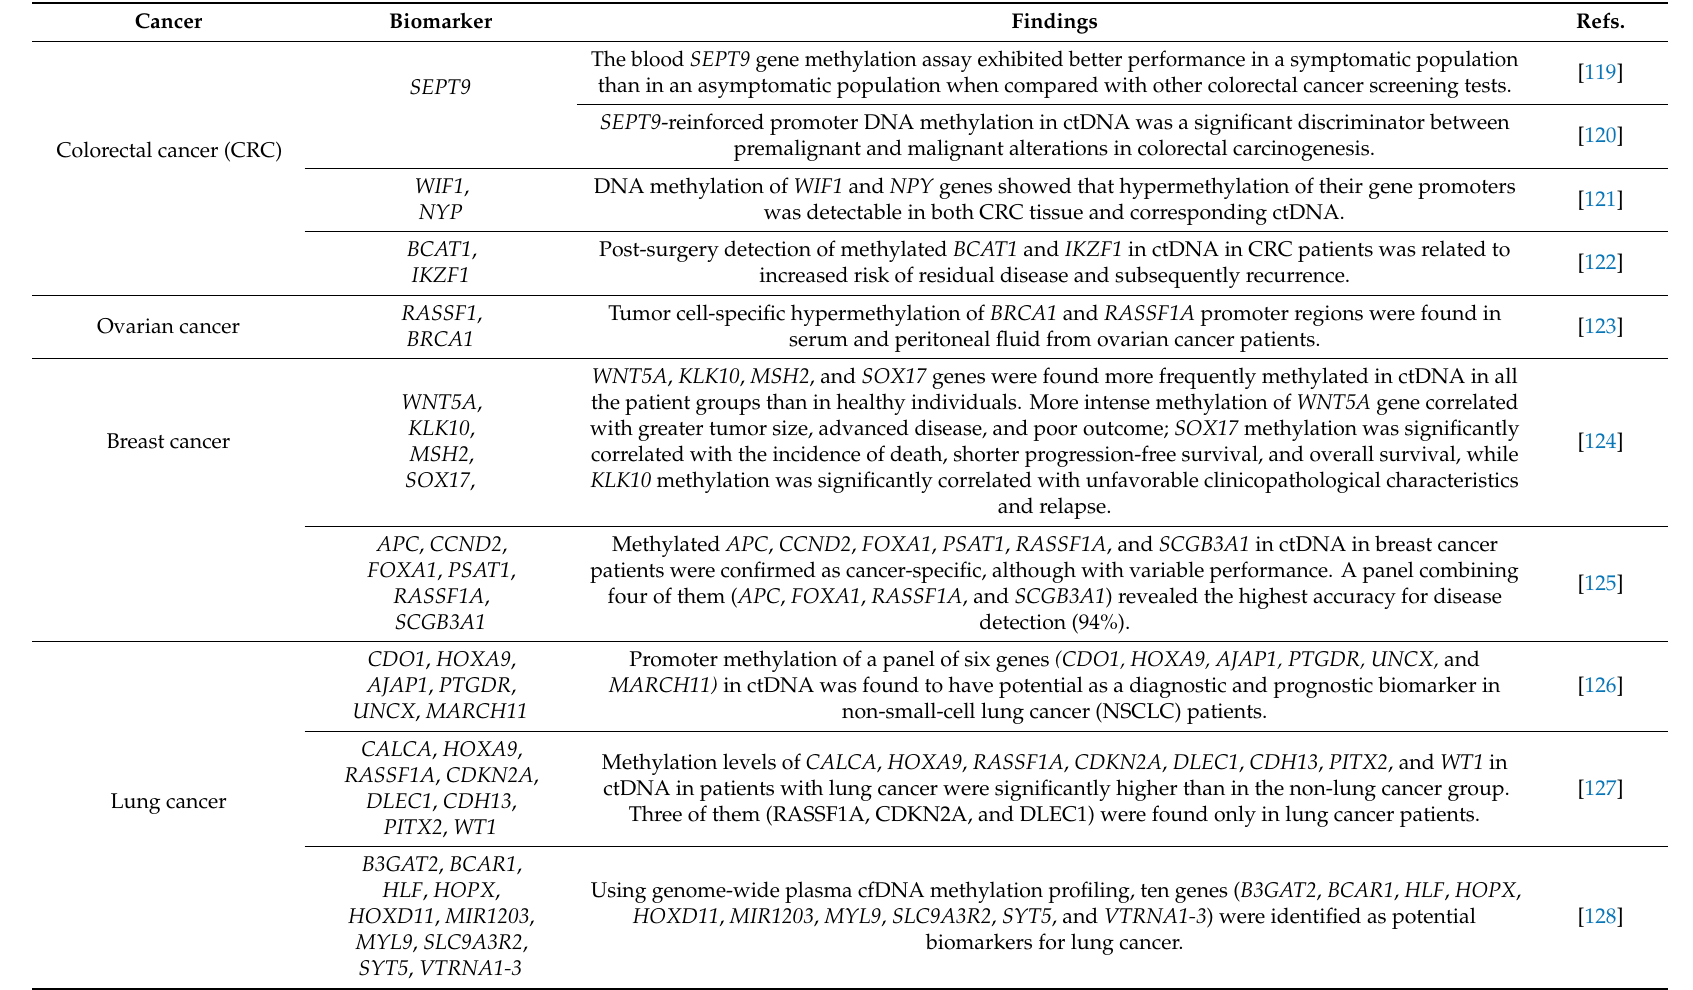
Table 1. The role of circulating cell-free tumor DNA (ctDNA) methylation in the detection of some common